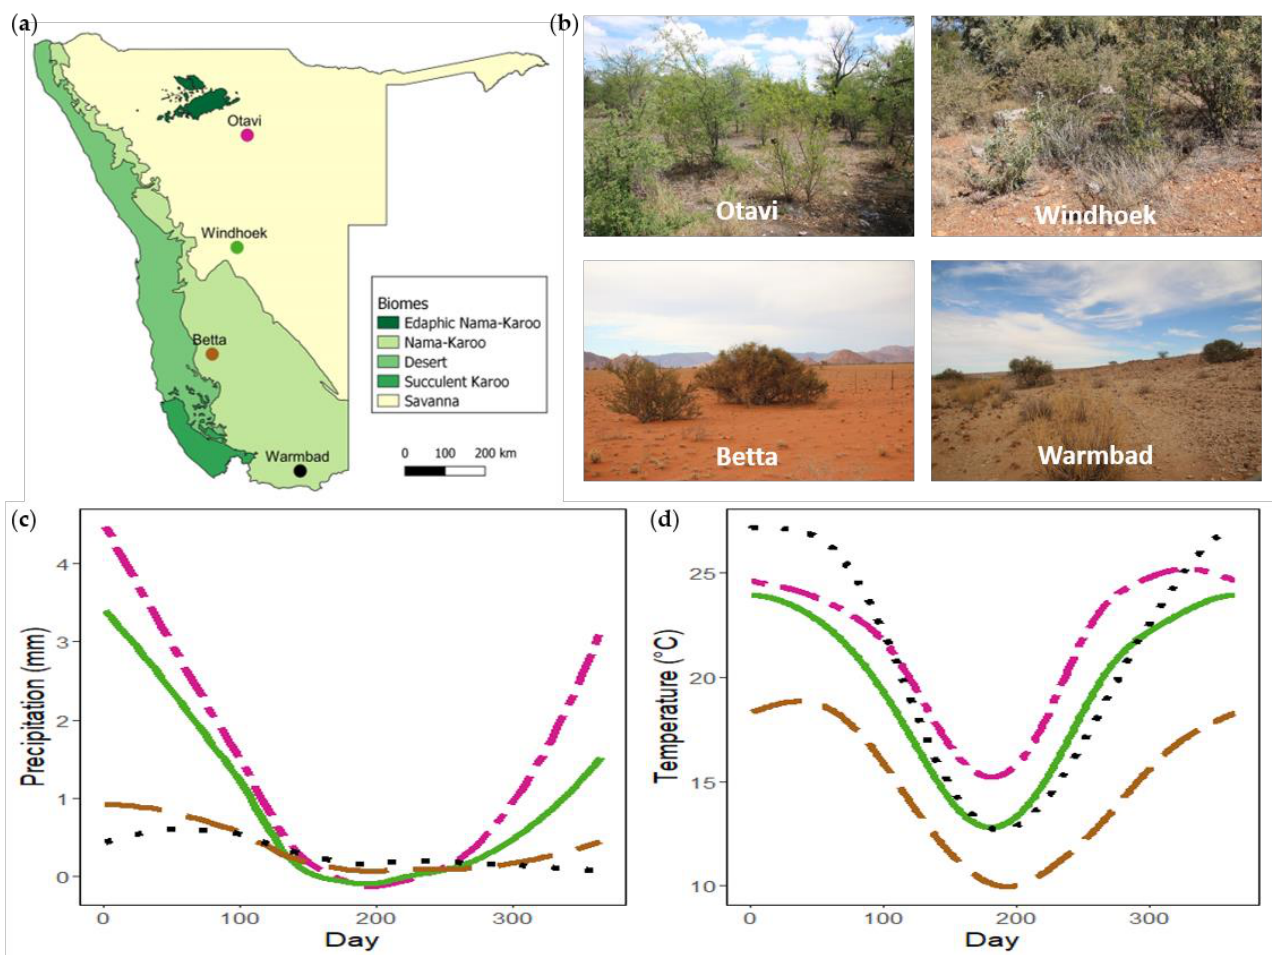
Figure 1. ( a ) Map of Namibia indicating the geographical location of the Stegodyphus dumicola Pocock, 1898 study populations with the different biomes (redrawn from [45]). ( b ) Site photos of the four sampling sites. ( c ) Daily average precipitation for each site. ( d ) Daily average temperature for each site. Vegetation was sampled using a modified point centred quarter (PCQ) [46] method.